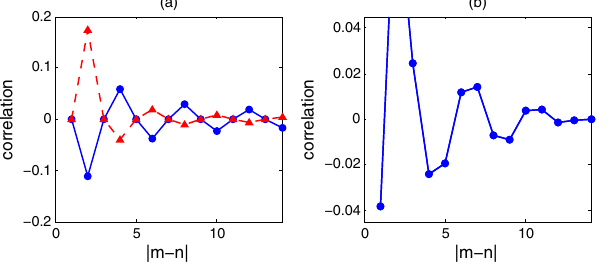
σ x (blue solid m n i FIG. 8. Correlation length ξ ð J 0 Þ for J ¼ 0 . 1 γ , found by fitting the exponential decay of h σ x diverges with critical exponent ν ¼ 1